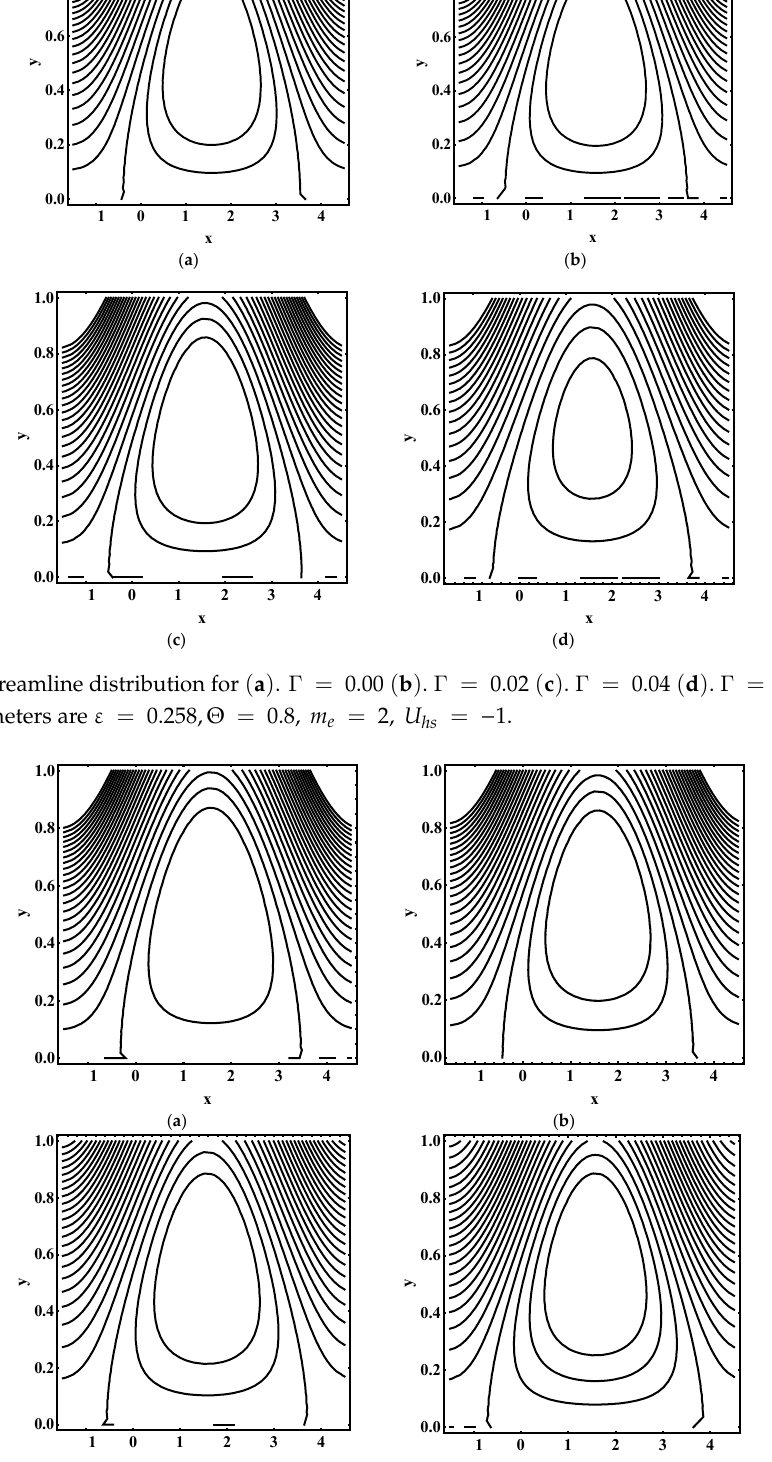
Figure 7. Streamline distribution for ( a ) . m e → 0 ( b ) . m e = 2 ( c ) . m e = 5 ( d ) . m e = 10, while other parameters are ε = 0.358, Θ = 0.7, Г = 0.01, U hs = −